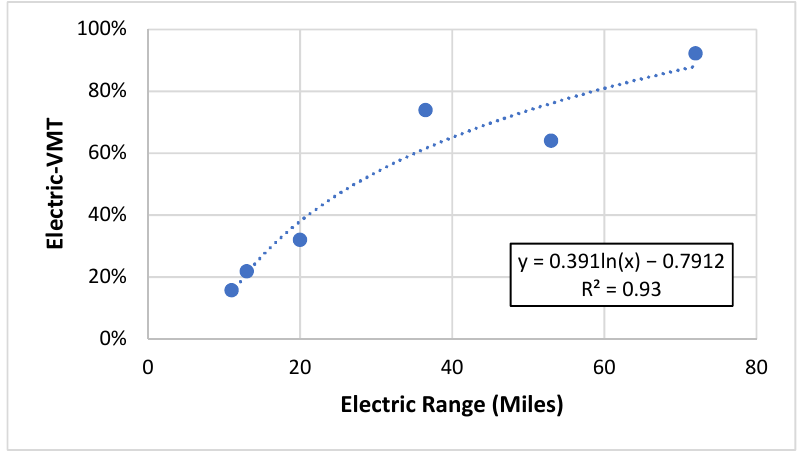
Figure A1. PHEV and BEVx Electric-VMT.